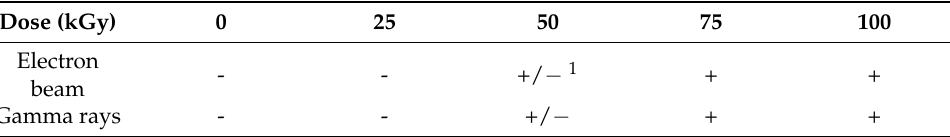
Table 2. Solubility of HDPE samples in boiling xylene. Presence of insoluble material (gel fraction) is marked by “+”, whereas “ − ” indicates absence of crosslinked residues. Dose (kGy)